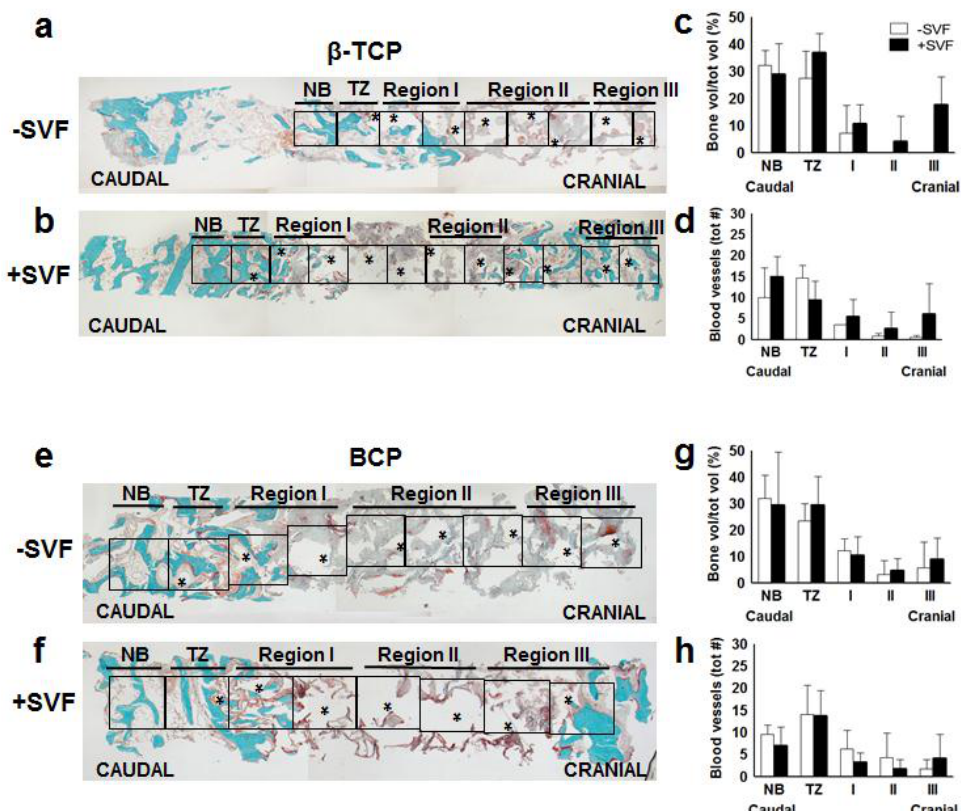
Figure 2. Histomorphometrical analysis of maxillary bone biopsies from patients treated with β - TCP ( a – d ) and BCP ( e – h ). Graphs a and b on the one side, and e and f on the other side represent typical bilateral biopsies from one and the same patient, while graphs c, d, g, and H represent quantifications of 3–5 samples. Midsagittal histological sections of each biopsy were stained with Goldner’s Trichome method [3], to distinct mineralized bone tissue (green) and unmineralized osteoid (red). Biopsies were divided in consecutive 1 mm 2 regions of interest (ROIs). The transition zone (TZ) indicates the first ROI where graft material (*) was observed when analyzing from the caudal to the cranial side of the biopsy. Bone ingrowth is determined from the sinus floor towards the cranial side of the biopsies. Original magnification is 100 × . Since the biopsies had different lengths we decided to define them in three regions after the transition zone. The ROI of the native bone (NB) next to the TZ was also analyzed. Percentage mineralized bone vol/tot vol from control sides without stem cells (white bars; n = 3), and study sides with stem cells (black bars; n = 5) from patients treated with β -TCP ( b ) or BCP ( f ) are depicted. Total number of blood vessels from control sides without stem cells (white bars; n = 3), and study sides with stem cells (black bars; n = 5) from patients treated with β -TCP ( d ) or BCP ( h ). β -tricalcium phosphate; BCP, biphasic calcium phosphate; NB, native bone; TZ, transition zone; SVF, stromal vascular fraction; bone vol/tot vol, bone volume/total volume; tot #, total number.